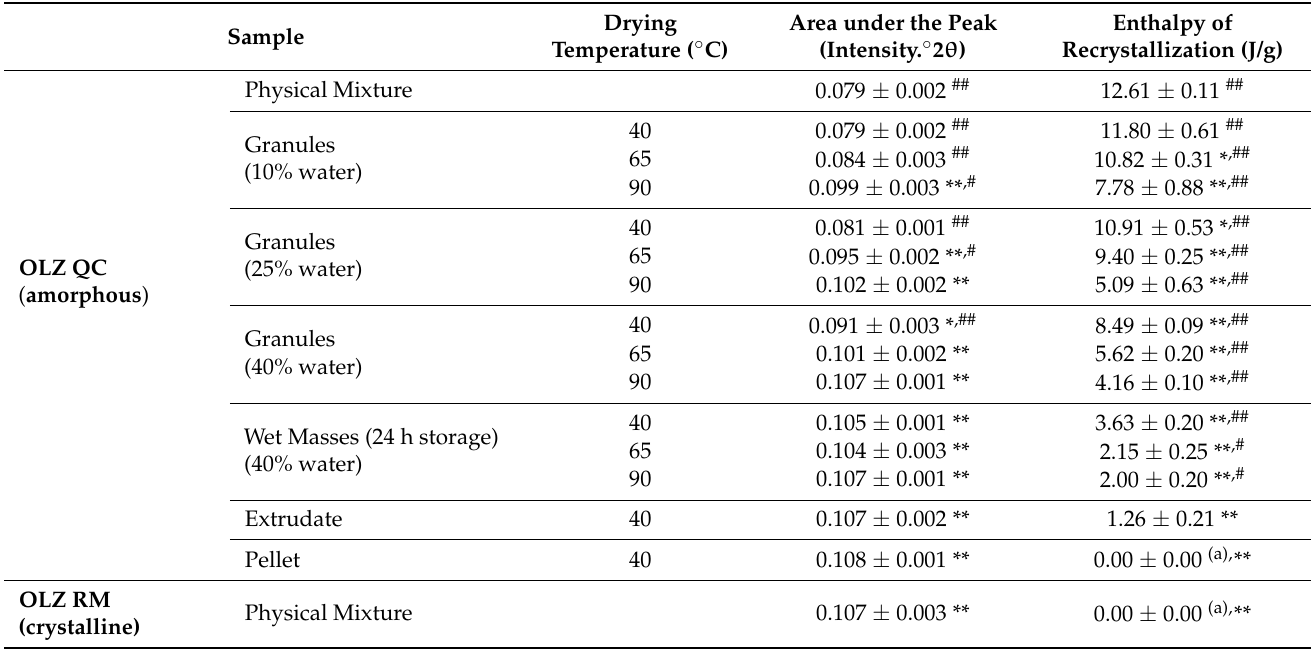
Table 1. Area under the peak (intensity. ◦ 2 θ , 20.7–21.2 ◦ 2 θ ) and enthalpy of recrystallization (J/g) of olanzapine present in physical mixtures (either crystalline or quench cooled olanzapine) and samples after